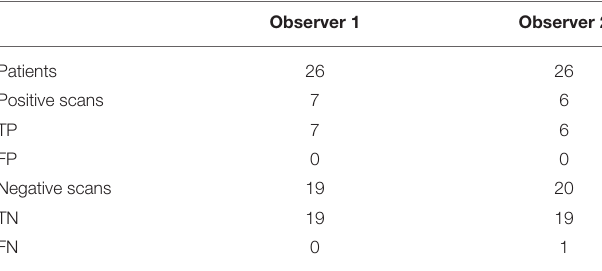
TABLE 3 | 99m Tc-Besilesomab-SPECT/CT